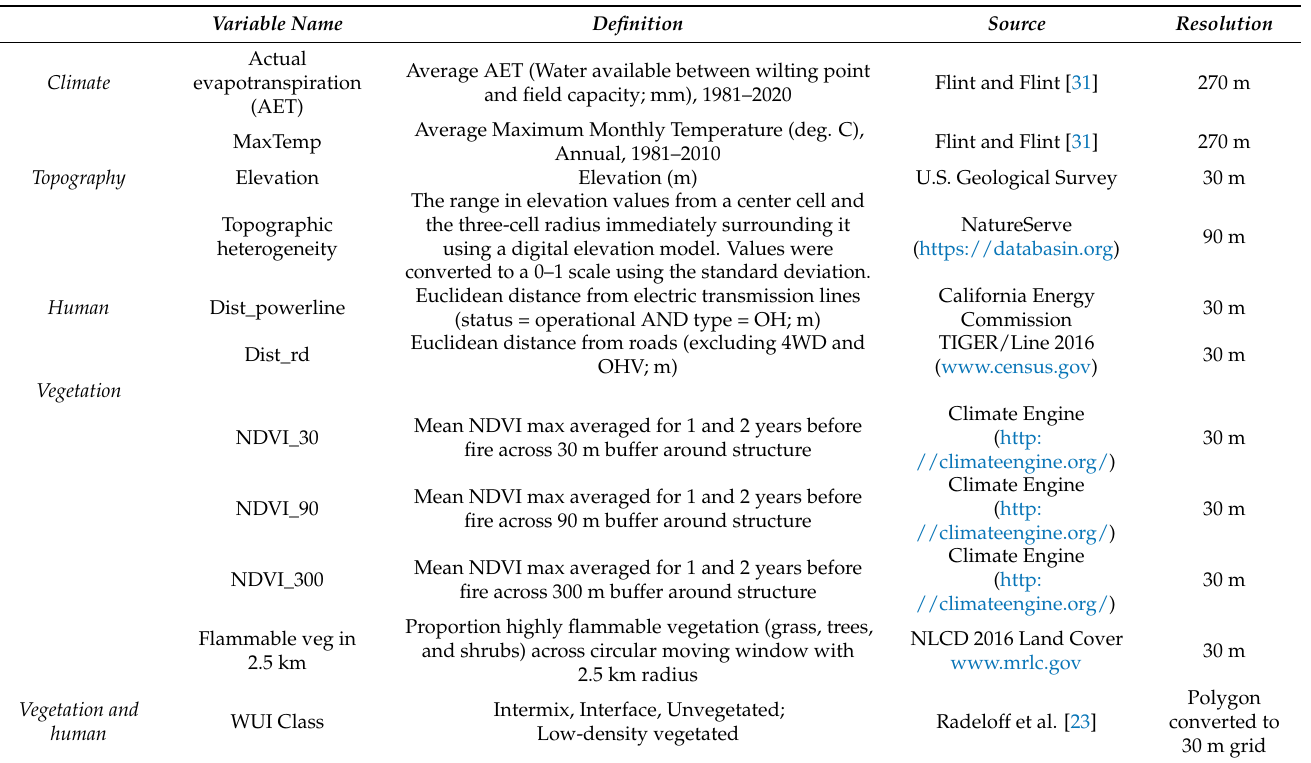
Table 1. Name and description of explanatory variables used to explain structure loss in